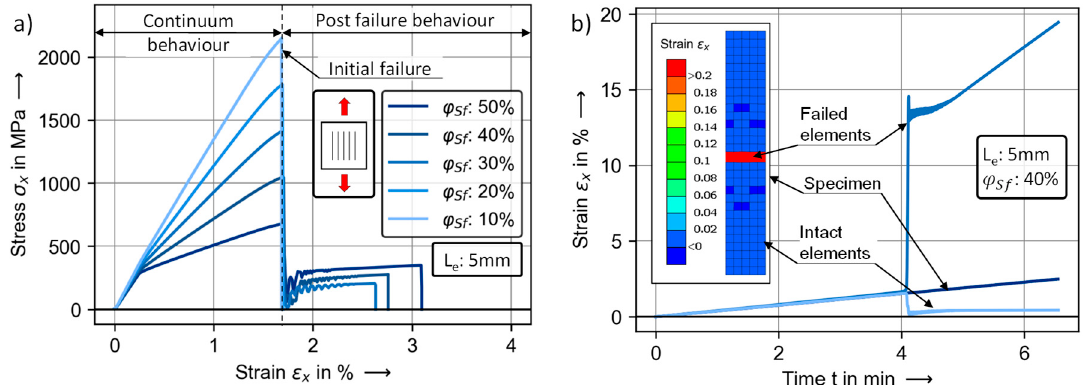
Figure 6. Variation of the steel fiber volume fraction in the FEA model with a fixed element edge length of 5 mm in ( a ) and local strain of an initially damaged and an intact element in the FEA model with 40 vol.% steel fibers and a fixed element edge length of 5 mm in ( b ).